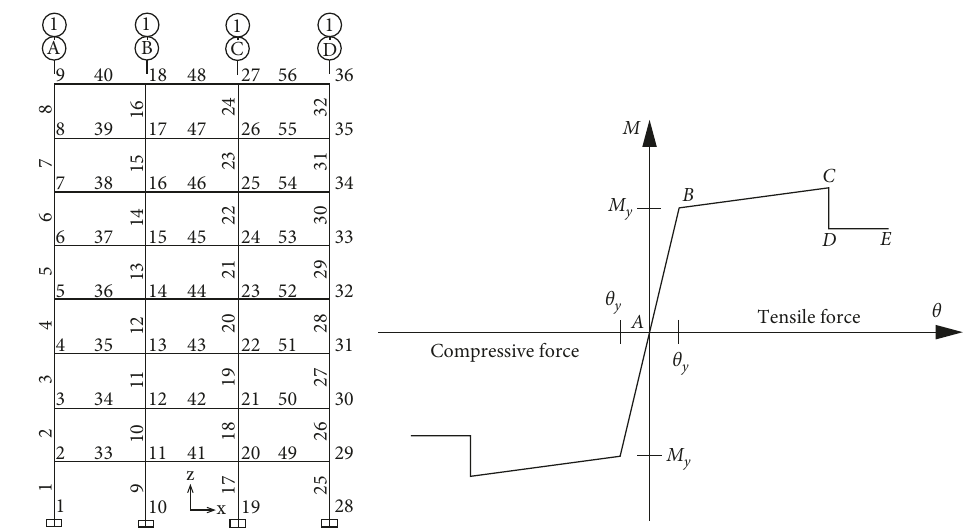
Figure 7: Constitutive relation of the hinge